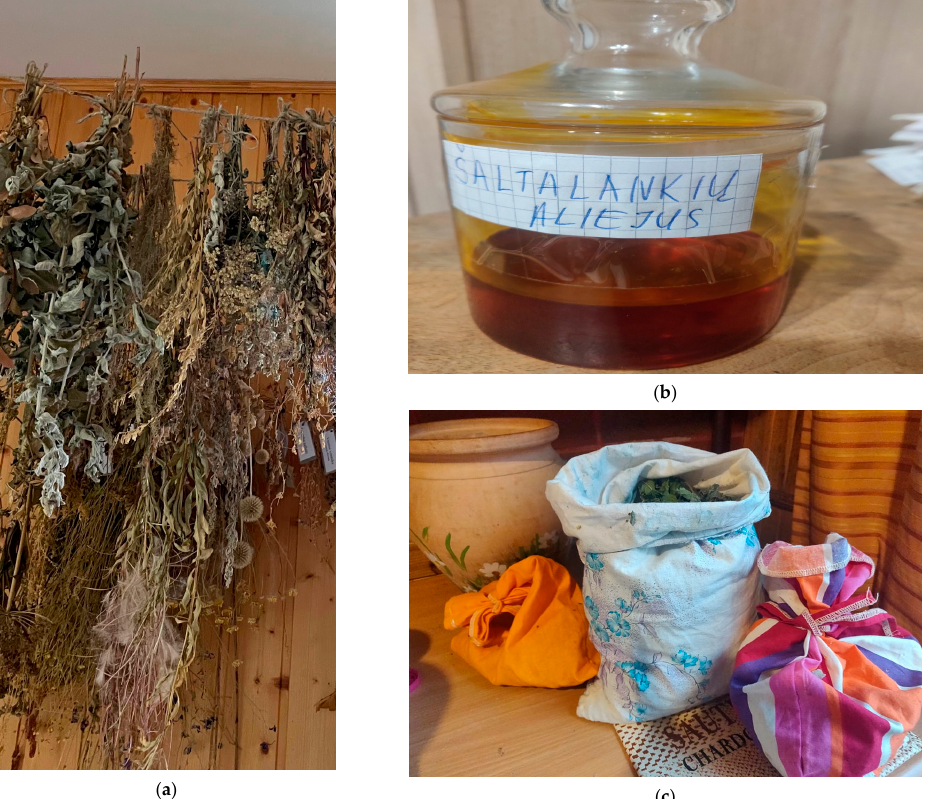
Figure 2. Preparation and storage conditions of medicinal raw materials used for skin diseases and/or cosmetics: ( a ) drying of various herbs; ( b ) prepared Sea buckthorn oil; ( c ) storage of dried plants in canvas bags.